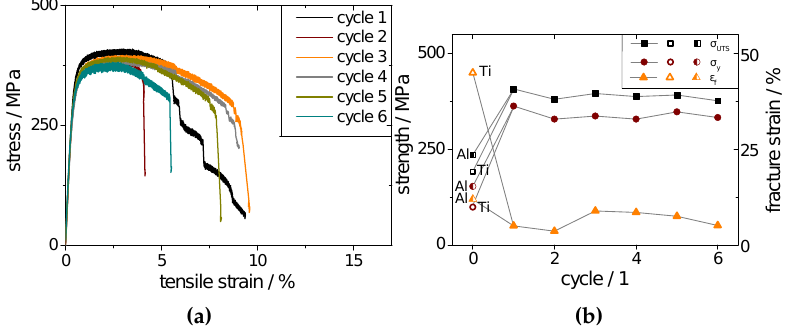
Figure 6. Engineering stress-strain curves of the five-layered Ti/Al composite accumulatively roll bonded with up to six cycles, including intermediate heat treatments (IHT) ( a ) and ultimate tensile strength ( σ UTS ), yield strength ( σ y ) and plastic strain ( ε ) of Al (half open symbols), Ti (open symbols) and the five-layered composite (filled symbols) ( b